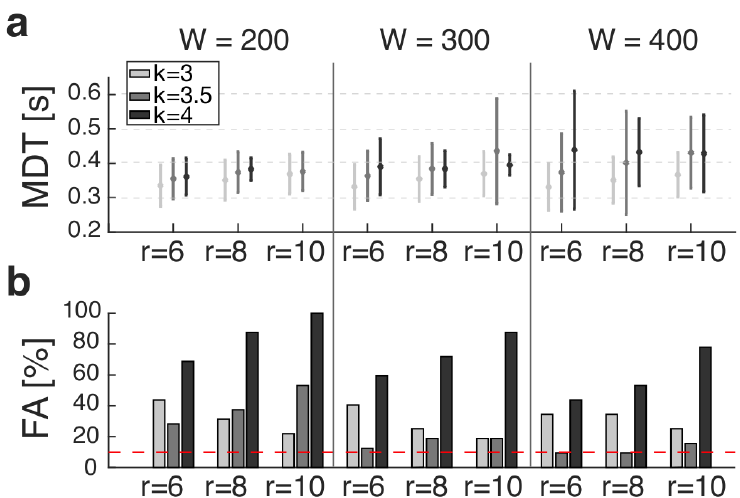
Figure 6. ( a ) Mean detection time (MDT) and ( b ) percentage of false alarms (FA) across all subjects and tripping trials. Light gray, gray and black lines represent values for k = [3, 3.5, 4], respectively. In panel (b), the dashed horizontal line represents an FA equal to 10%.